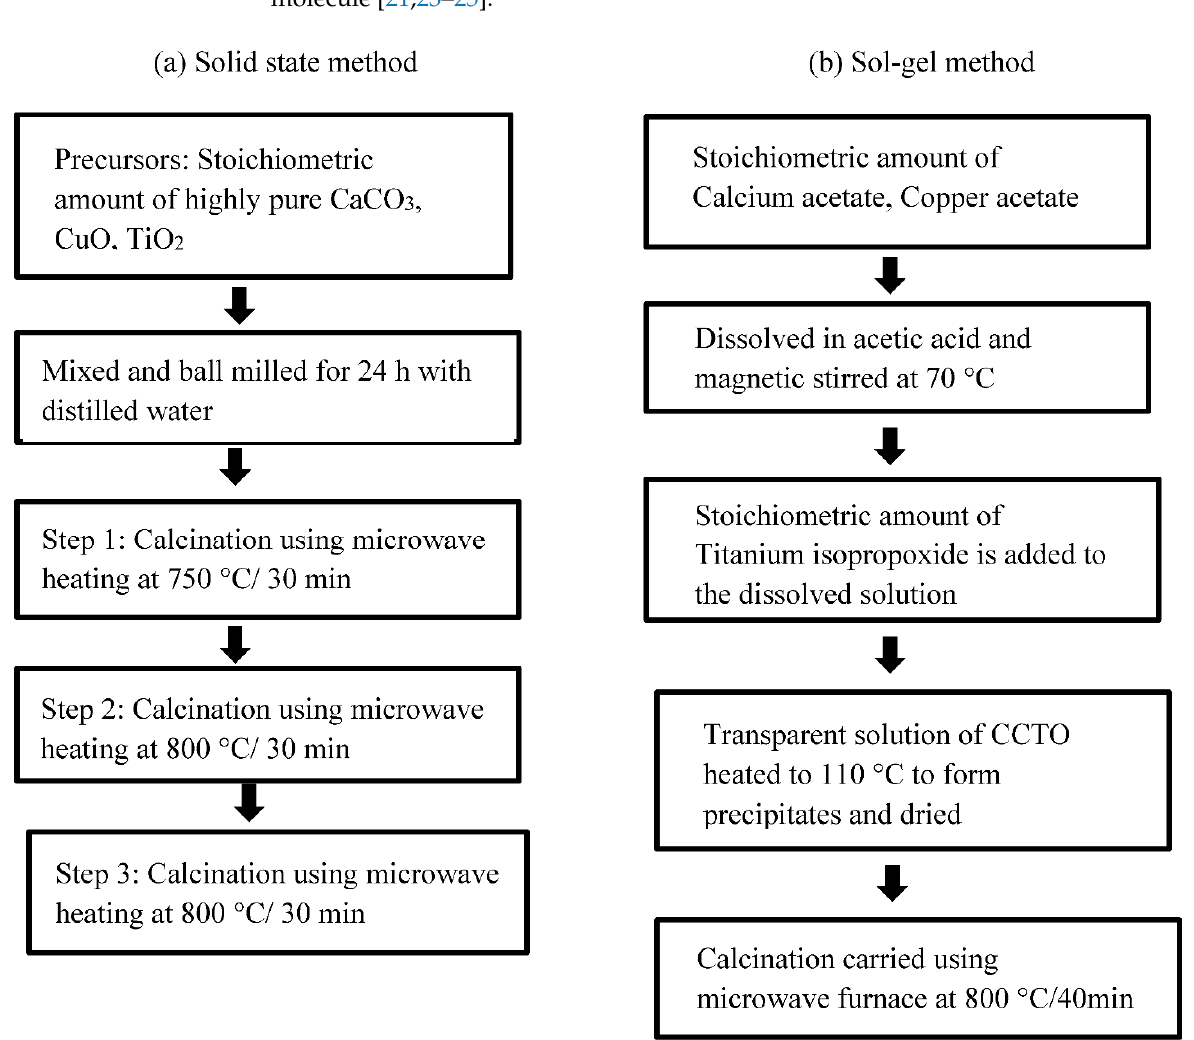
Figure 1. Flowchart of microwave synthesis of CCTO from ( a ) solid state precursors ( b ) Sol–gel